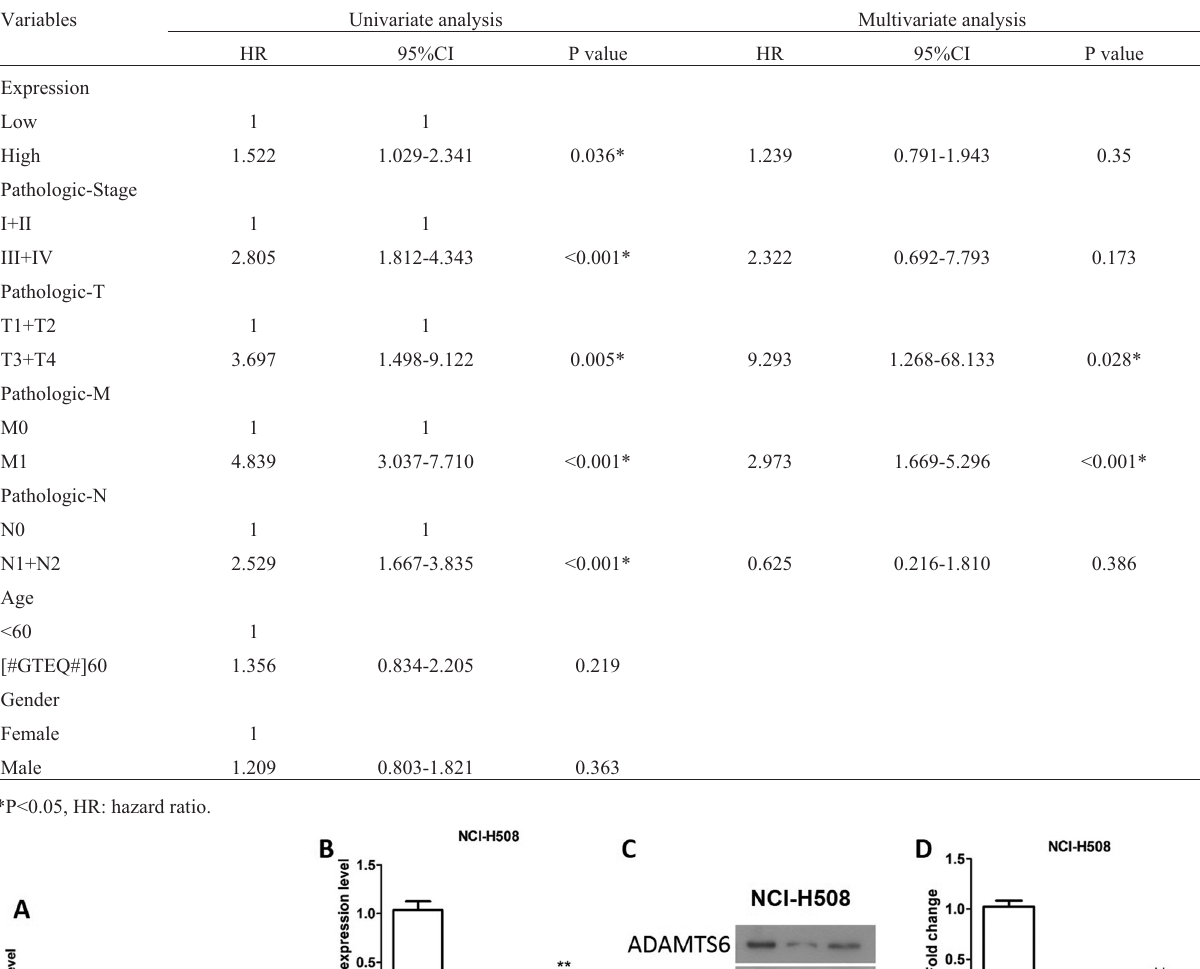
Table 3 - Cox proportional hazards model analysis of clinic pathologic features for overall survival of ADAMTS6 in colon cancer patients.